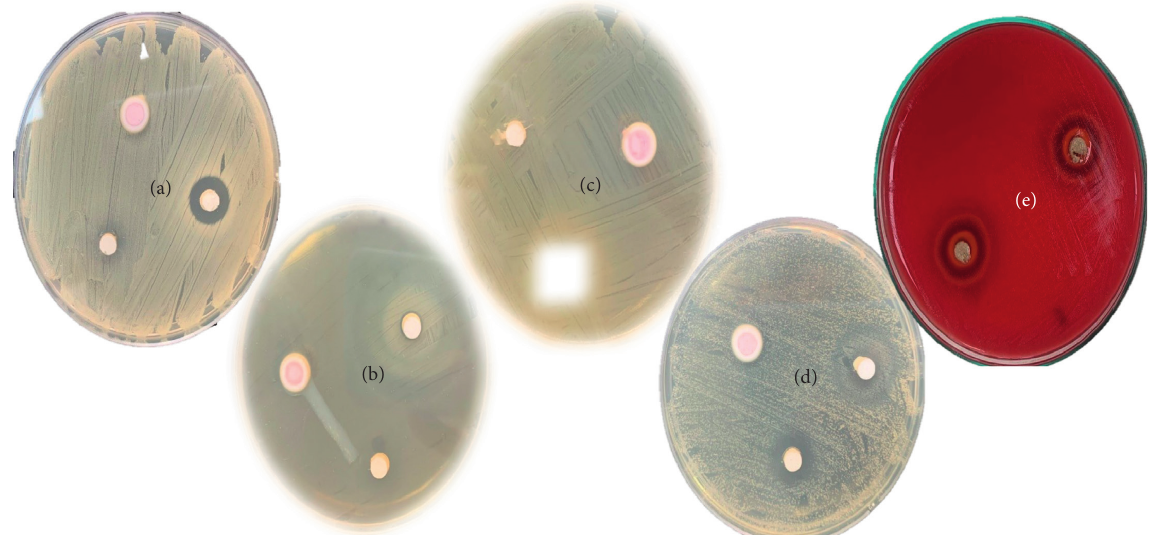
Figure 2: Measurement of inhibition halos against the different microorganisms evaluated. Group A: S. aureus ATCC ® 25923 ™ ; group B: E. coli ATCC ® 25922 ™ ; group C: E. faecalis ATCC ® 29212 ™ ; group D: C. albicans ATCC ® 10231 ™ ; and group E: S. mutans ATCC ® 25175 ™